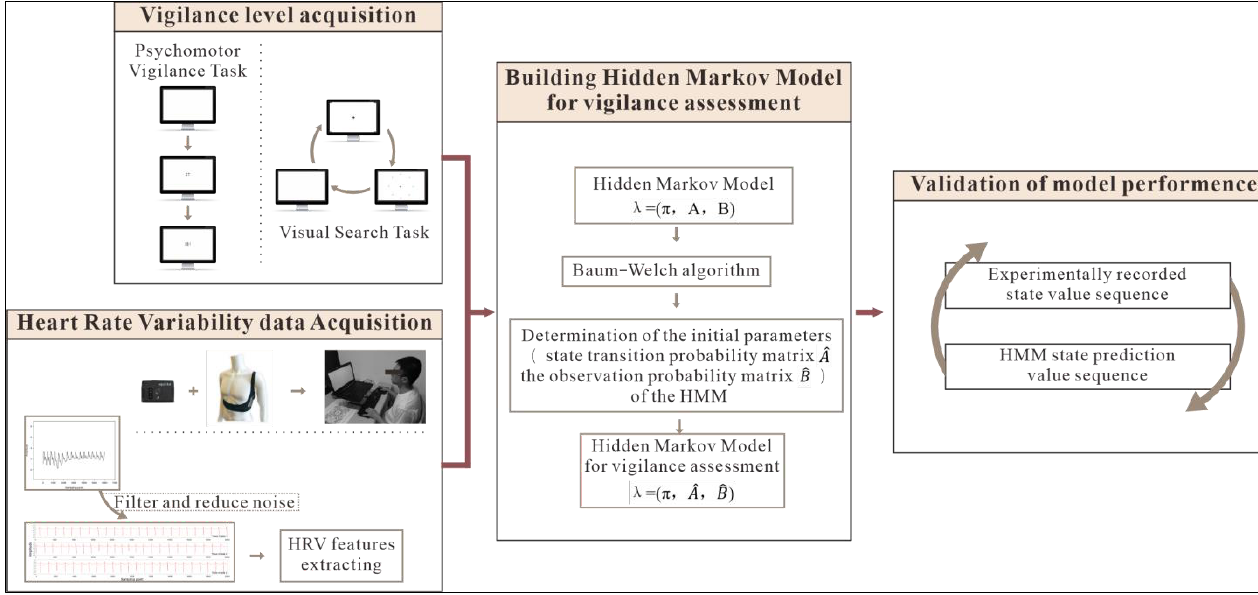
Figure 1. Research overview.